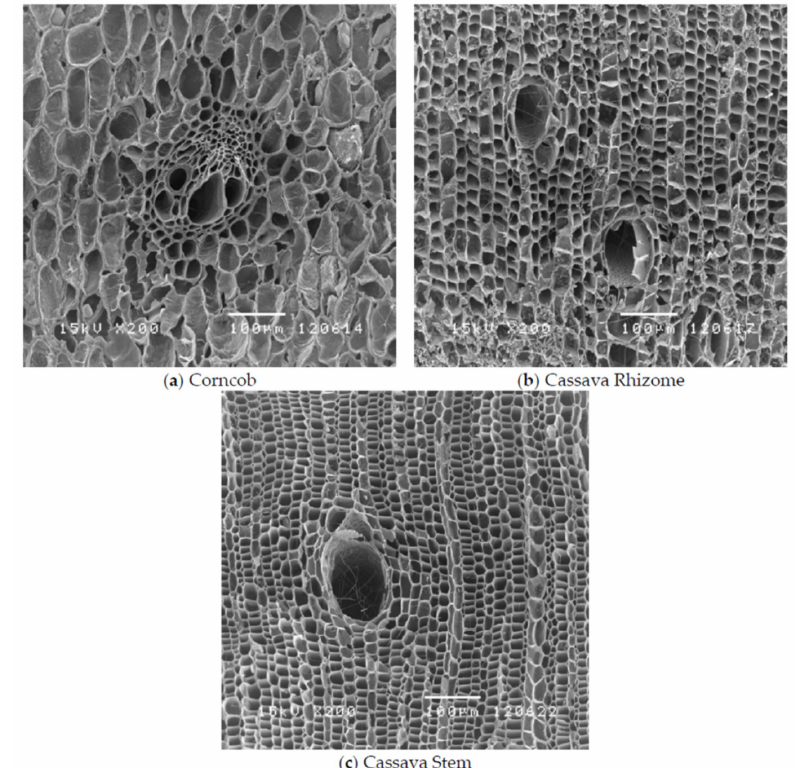
Figure 2. SEM images showing biochar produced from different lignocellulosic feedstocks ( a ) corncob ( b ) cassava rhizome ( c ) cassava stem. Each feedstock source has a distinctive morphology which is retained in the biochar after carbonization. This image is taken from [29] from Applied Sciences Open Access journal MDPI